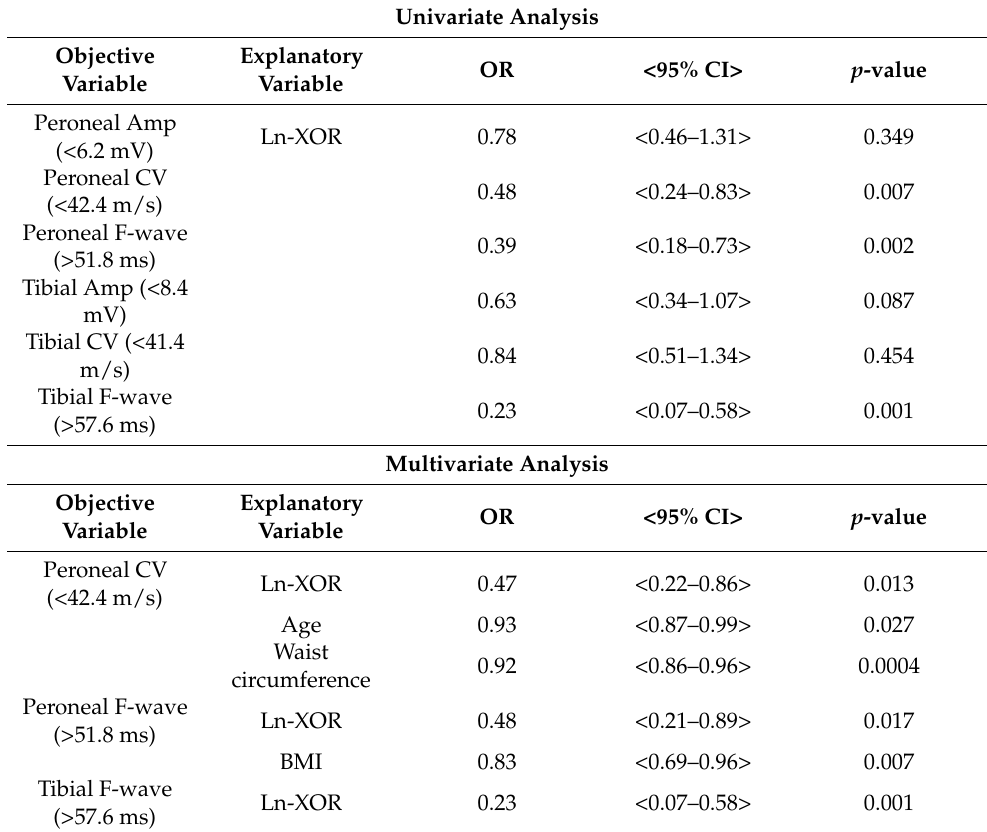
Table 2. Univariate and multivariate regression analysis of NCS